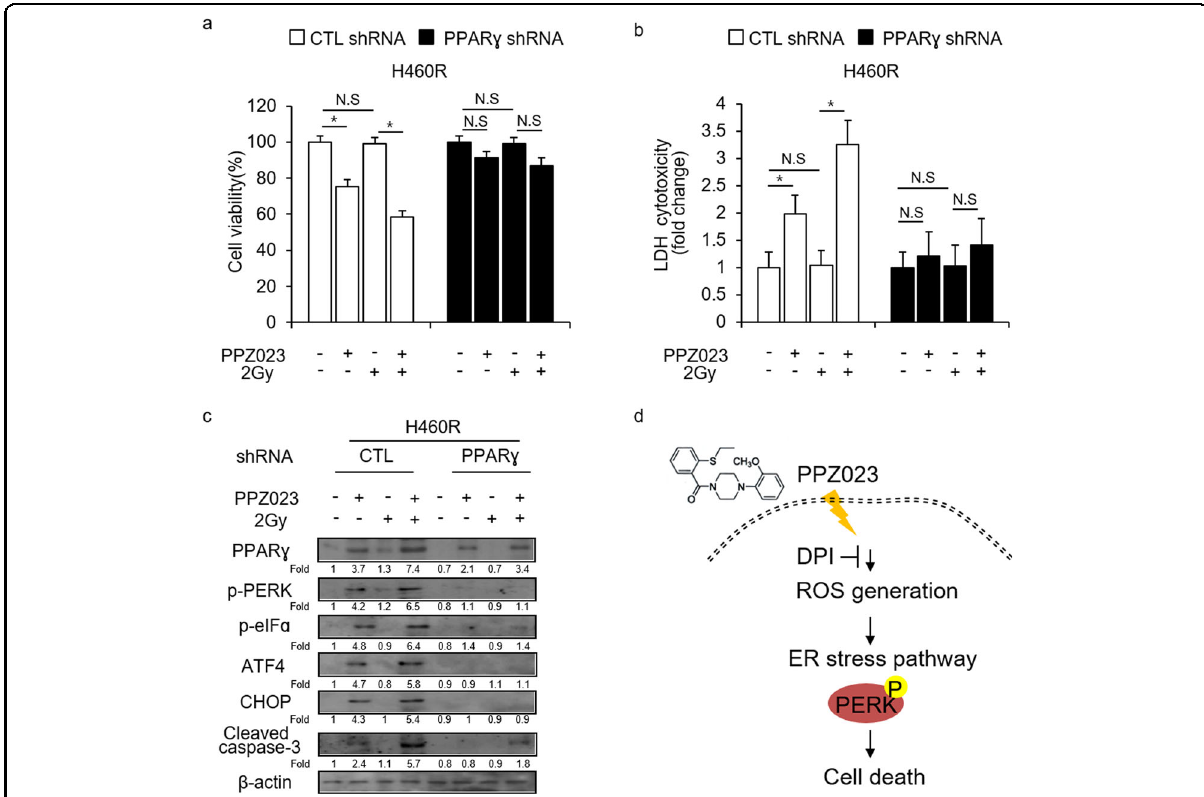
Fig. 8 Inhibition of PPAR ɣ with a speci fi c- shRNA suppresses PPZ023 + 2 Gy radiation-induced cell death in radioresistant H460R cells. a – c After H460R cells were transfected with the PPAR ɣ shRNA, stable PPAR ɣ -knockdown H460R cell lines were established. These cells were then treated with PPZ023 (25 μΜ , 24 h) after 2 Gy radiation exposure, and cell viability and LDH assays were performed along with western blot analyses of PPAR ɣ , p-PERK, p-eIF2 ɑ , ATF4, CHOP, and cleaved caspase-3; * p < 0.05. β -Actin was used as the protein loading control. d Schematic representation of ER stress and cell death pathways stimulated by PPZ023 in NSCLC and radioresistant NSCLC